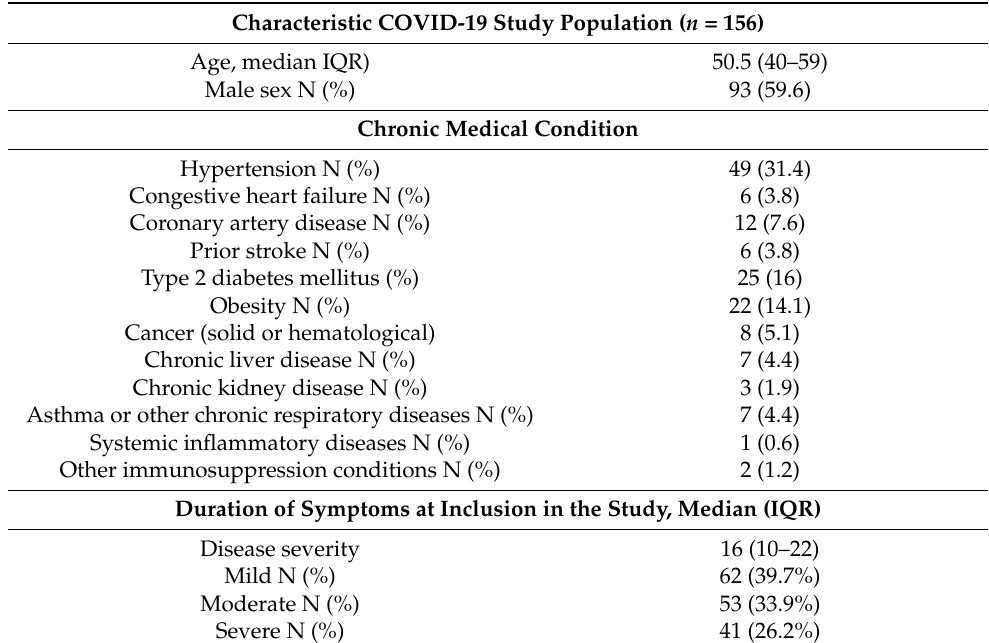
Table 1. Clinical characteristics and demographics of patients included in the study.